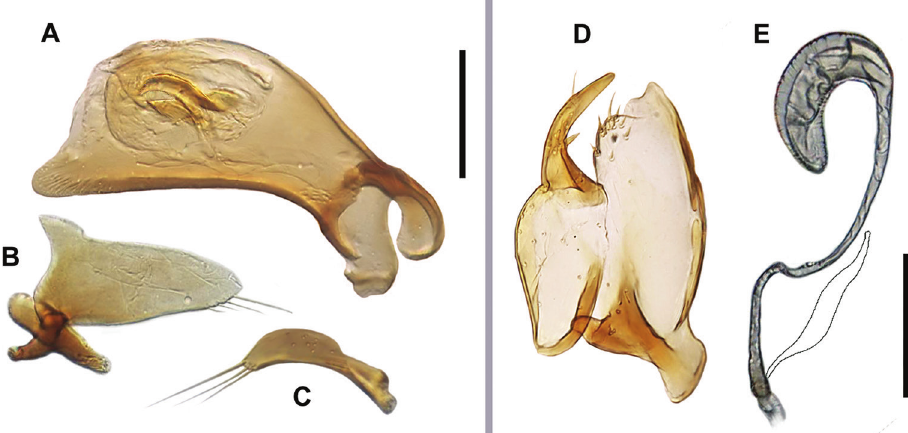
Figure 2. Digital images of male and female genitalia of A. felicianus sp. nov. (4mi SW of Jackson, West Feliciana Parish, Louisiana). Male genitalia A median lobe, right lateral aspect B left paramere, left lateral aspect C right paramere, right lateral aspect. Female genitalia D ovipositor sclerites E spermatheca (sper- mathecal gland manually restored). Scale bars: 0.1